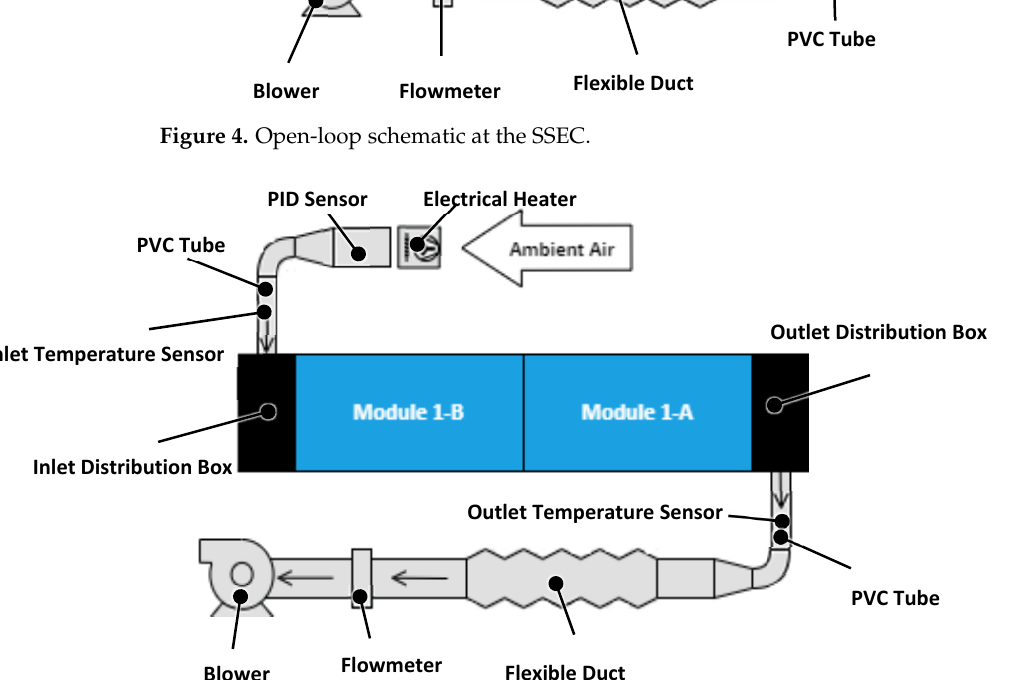
Figure 5. Closed ‐ loop schematic at the SSEC. Figure 5. Closed-loop schematic at the